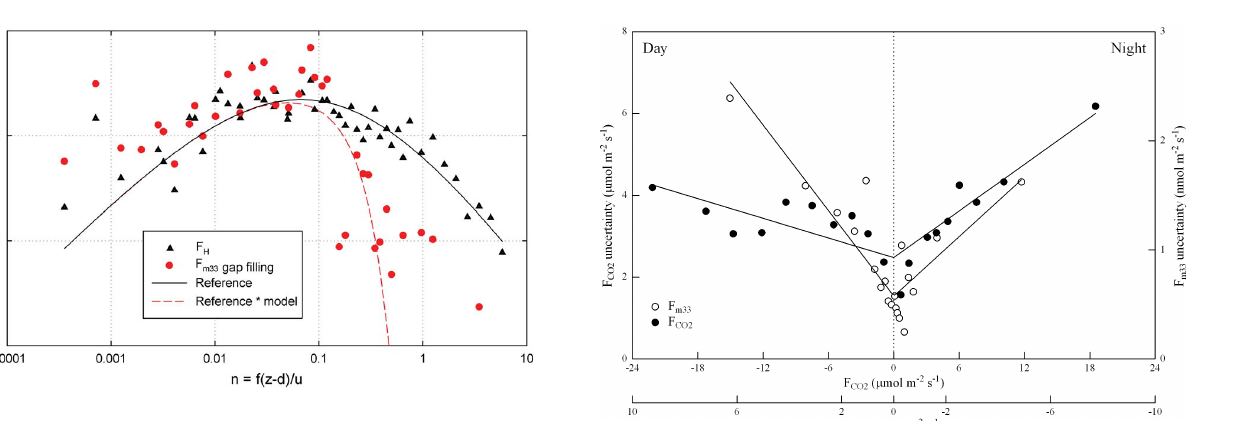
Fig. 4. Comparison of the cospectra for the sensible heat (black tri- angles) and methanol flux (red points; gap filling method) together with the cospectral reference model (Wohlfahrt et al., 2005; black line) and the reference model attenuated by a series of transfer func- tions which account for high- and low-pass filtering of the methanol flux (red dashed line).